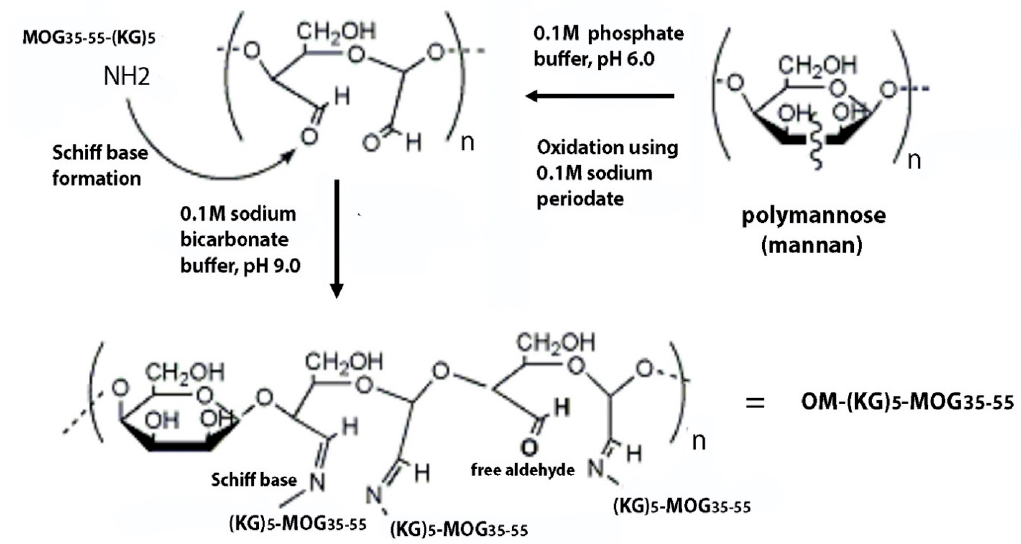
Figure 7. The mechanism of cis diol cleavage. Synthetic scheme of conjugation reaction of peptide with oxidized mannan [35].